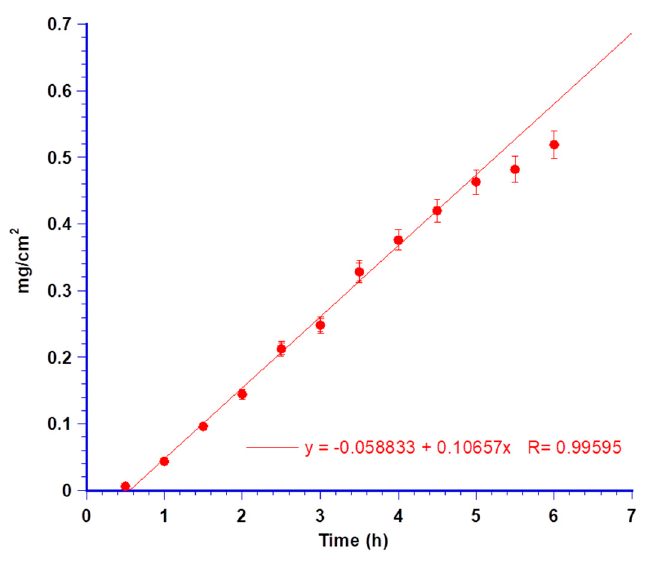
Figure 12. Permeation data of MTR per cm 2 throughout porcine buccal mucosa and linear fitting at the steady-state concentrations. Values are presented as means ± SE ( n = 6).